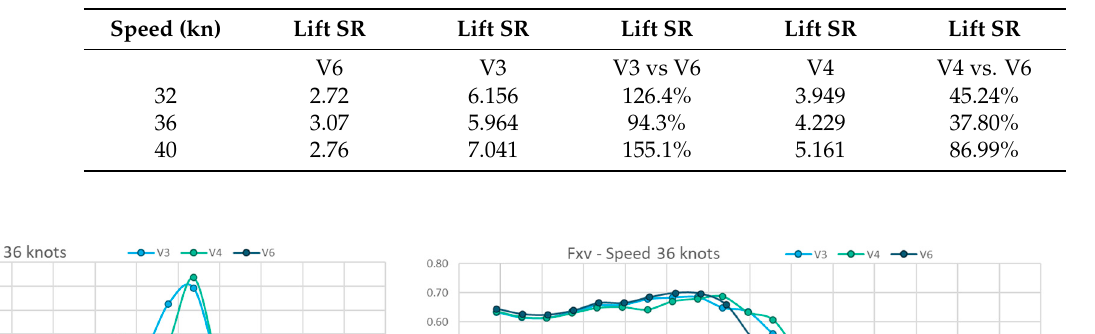
Table 10. Lift computed on the hull and SR.